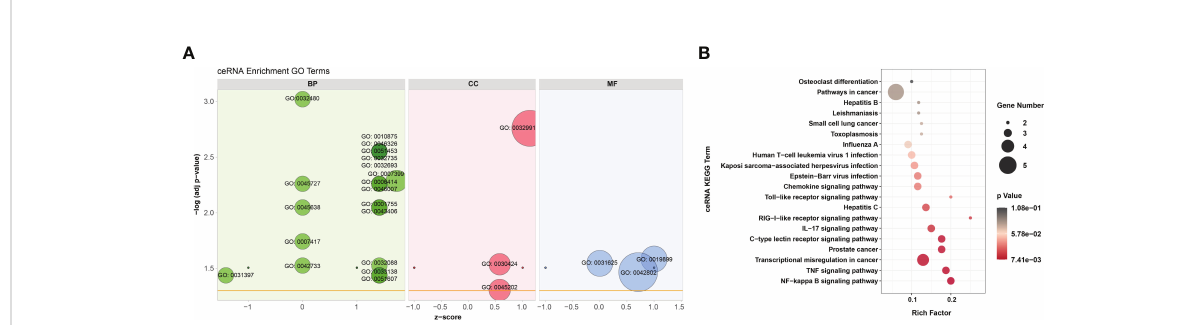
FIGURE 7 GO annotation and KEGG enrichment of dif-mRNAs involved in ceRNA networks. (A) Z-score in the GO bubble diagram was equal to the total number of transcriptional increased dif-mRNAs minus the total number of decreased dif-mRNAs and then divided by the square root of the total number of dif-mRNAs in a certain GO term and was used to measure whether the term was upregulated or downregulated overall. The size of the solid circulars represented the number of enriched dif-mRNAs under speci fi c GO terms. GO: 0032480: negative regulation of type I interferon production, GO: 0045727: positive regulation of translation, GO: 0045638: negative regulation of myeloid cell differentiation, GO: 0007417: central nervous system development, GO: 0042733: embryonic digit morphogenesis, GO: 0031397: negative regulation of protein ubiquitination, GO: 0010875: positive regulation of cholesterol ef fl ux, GO: 0046326: positive regulation of glucose import, GO: 0051453: regulation of intracellular pH, GO: 0032735: positive regulation of interleukin-12 production, GO: 0032693: negative regulation of interleukin-10 production, GO: 0007399: nervous system development, GO: 0006414: translational elongation, GO: 0046007: negative regulation of activated T cell proliferation, GO: 0001755: neural crest cell migration, GO: 0043406: positive regulation of MAP kinase activity, GO: 0032088: negative regulation of NF-kappaB transcription factor activity, GO: 0033138: positive regulation of peptidyl-serine phosphorylation, GO: 0051607: defense response to virus, GO: 0032991: protein-containing complex, GO: 0030424: axon, GO: 0045202: synapse, GO: 0019899: enzyme binding, GO: 0031625: ubiquitin protein ligase binding, GO: 0042802: identical protein binding. (B) Top 20 KEGG pathways were selected to display. Rich factor indicated the ratio of dif-mRNAs enriched to the speci fi c pathway. The size of and the color of the solid circulars represented the number of enriched dif-mRNAs and signi fi cance of the enrichment, respectively.